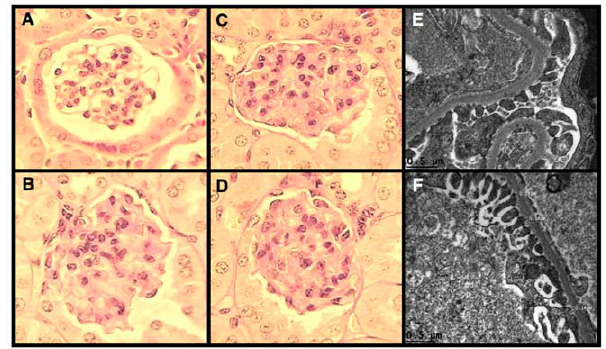
Figure 4. Glomerular histopathology of diabetic Akita mice. Photomicrographs of mouse kidneys were taken using tissue samples prepared from mice at 30-weeks of age. (A) A representative picture from a control mouse (score of 0). (B–D) Moderate mesangial expansion